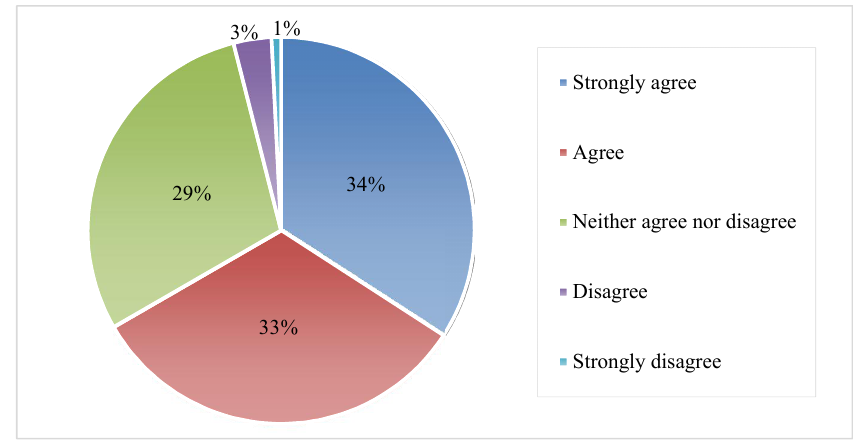
Figure 4. Pie chart of respondents’ perceptions regarding challenges in their manufacturing pharmaceutical companies.